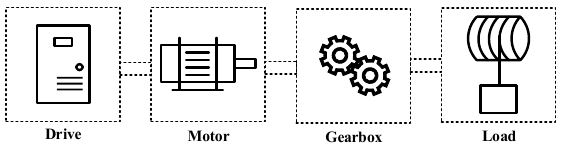
Figure 3: Design optimization problem of electric driv- etrain (Pawlus et al.,